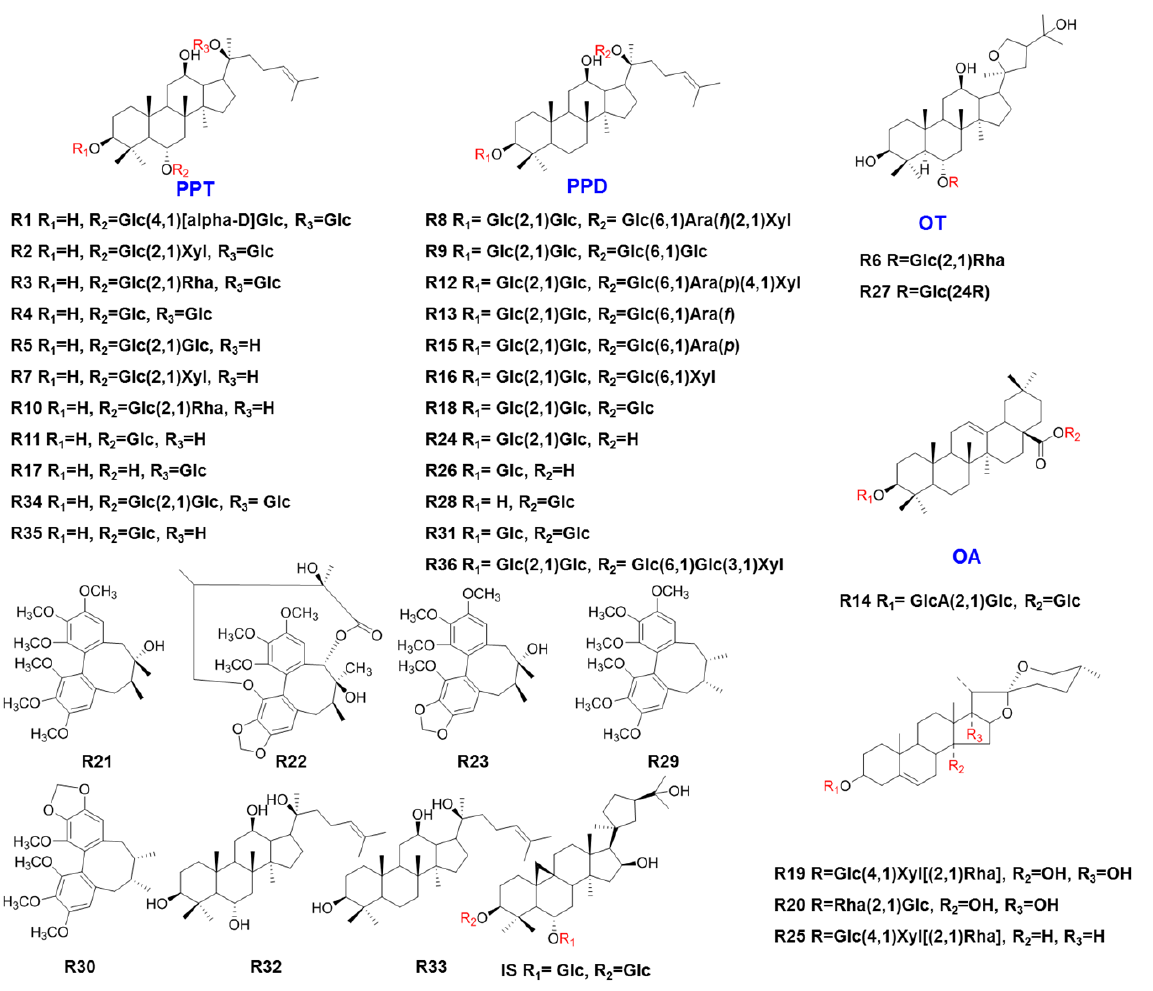
Figure 5. Structures of the 36 reference compounds. PPD, 20( S )-protopanaxadiol; PPT, 20( S )-protopanaxatriol; OT, octillol; OA, oleanolic acid; glc, glucosyl residue; ara, arabinosyl residue; xyl, xylosyl residue. Hongshen (HS, Ginseng Radix et Rhizoma Rubra), Maidong (MD, Ophiopogonis Radix), and Wuweizi (WWZ, Schisandrae Chinensis Fructus) extracts and YQFMI